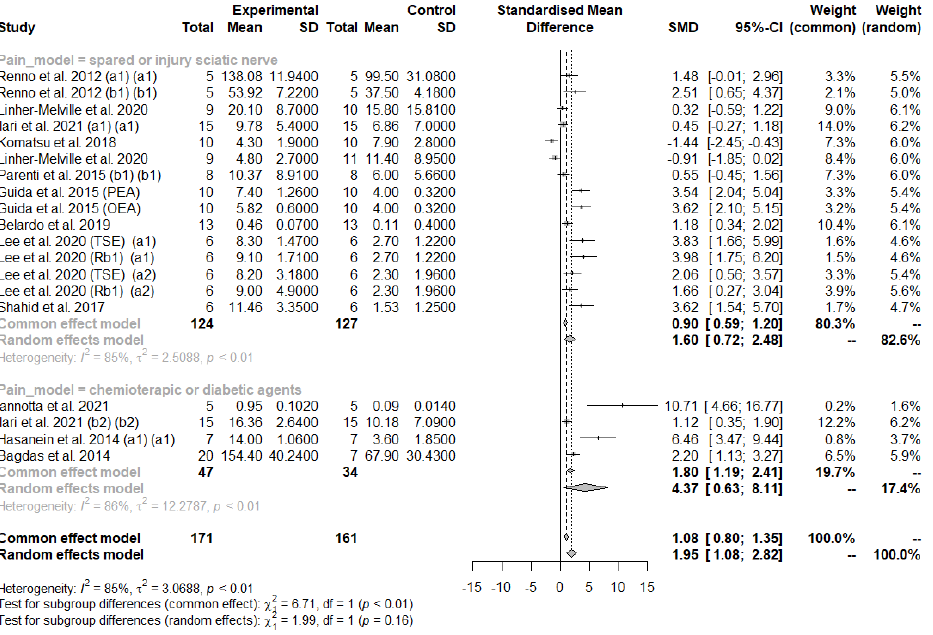
Figure 8. Forest plot showing the nutraceutical effects in the subgroup (pain model) of mechanical allodynia/hyperalgesia, observed by measuring the withdrawal threshold in the injured paw. SD, standard deviation; SMD, standardized mean differences; CI, confidence.